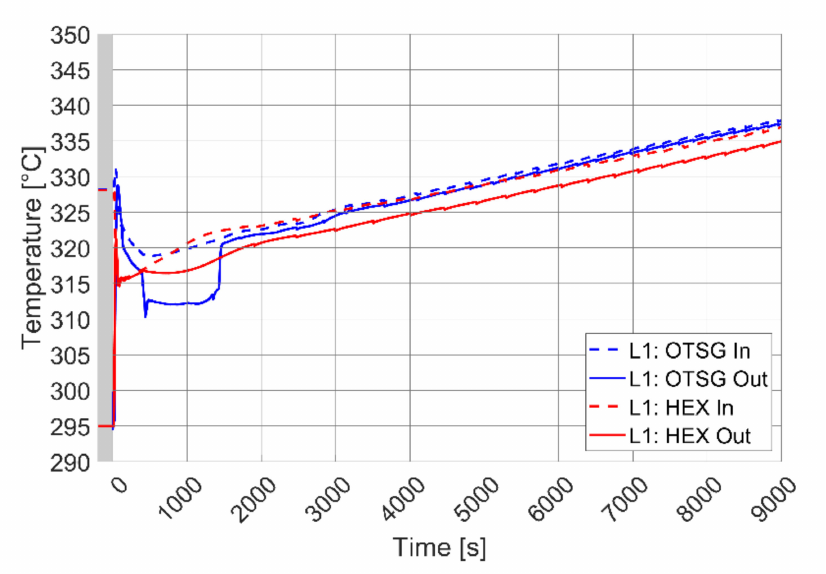
Figure 14. Partial LOFA on BZ PHTS without loss of off-site power, new BB MCPs management strat- egy: BZ PHTS water temperatures at loop 1 OTSG inlet & outlet and FW PHTS water temperatures at loop 1 HEX inlet & outlet (full